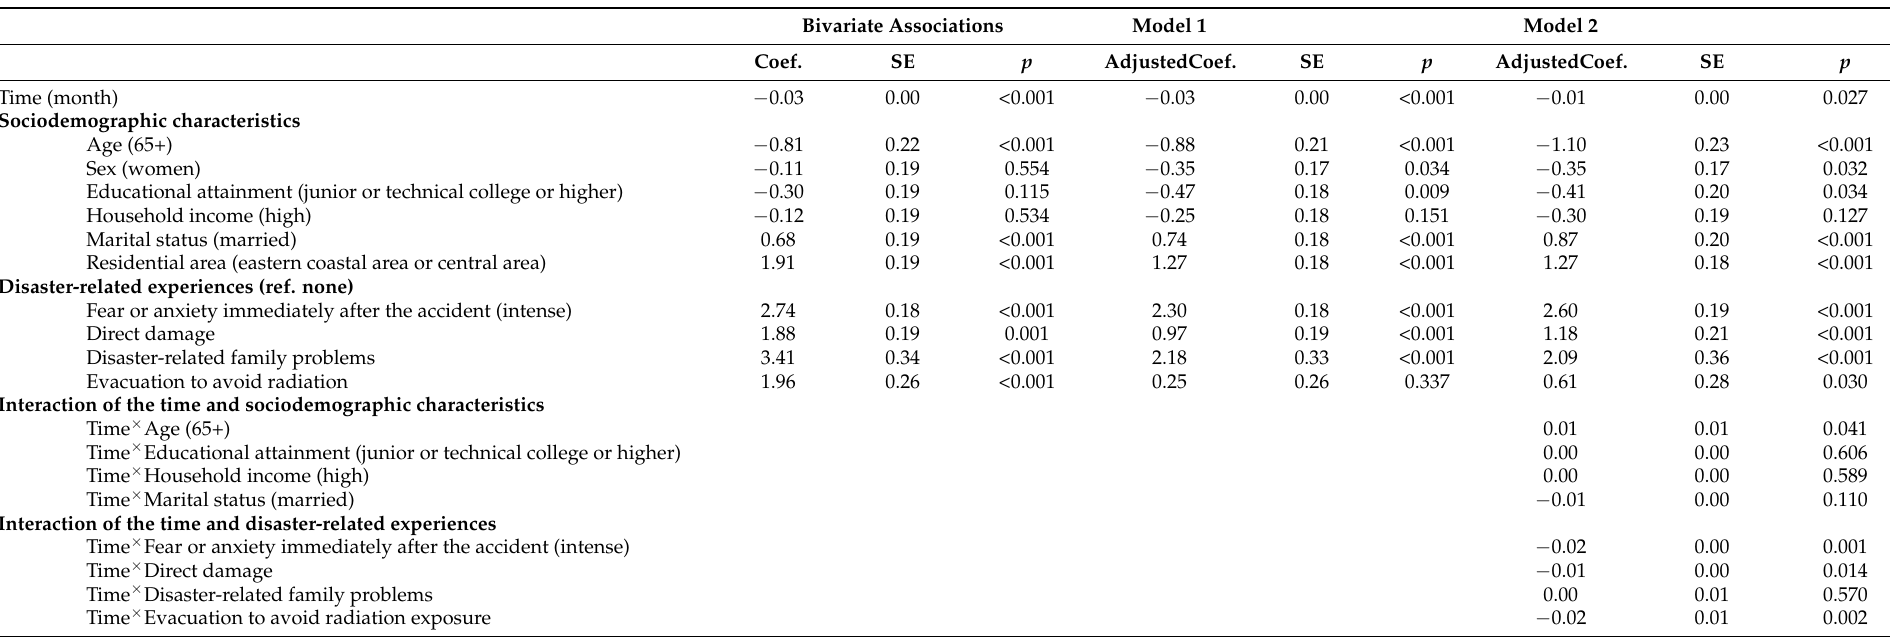
Table 2. The effects of time, sociodemographic characteristics, and disaster-related experiences on worry about radiation from five years after the Fukushima nuclear power plant accident. (N =